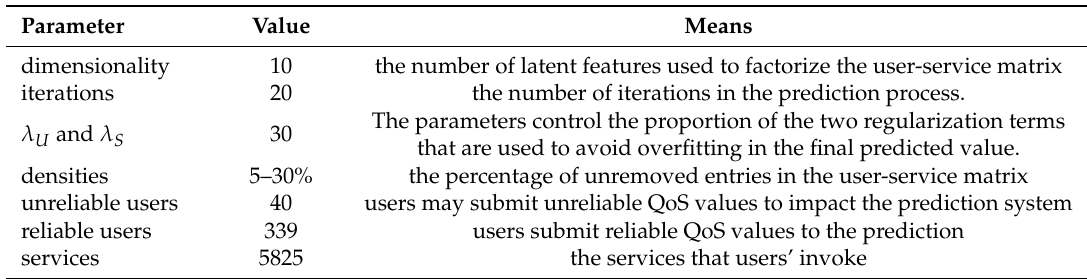
Table 2. Detail simulation parameters in our